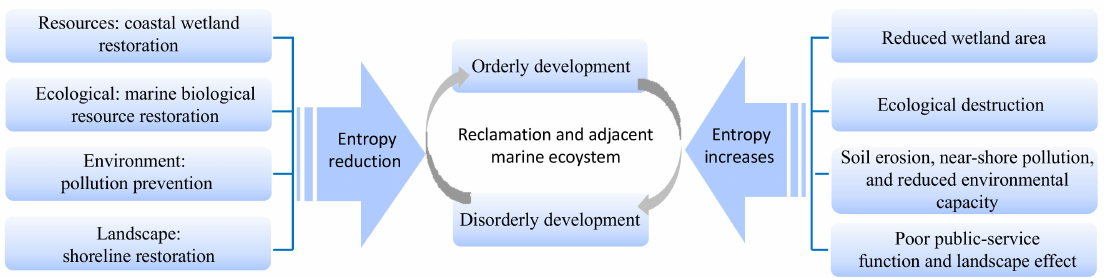
Figure 9. Reclamation projects and adjacent marine ecosystems development